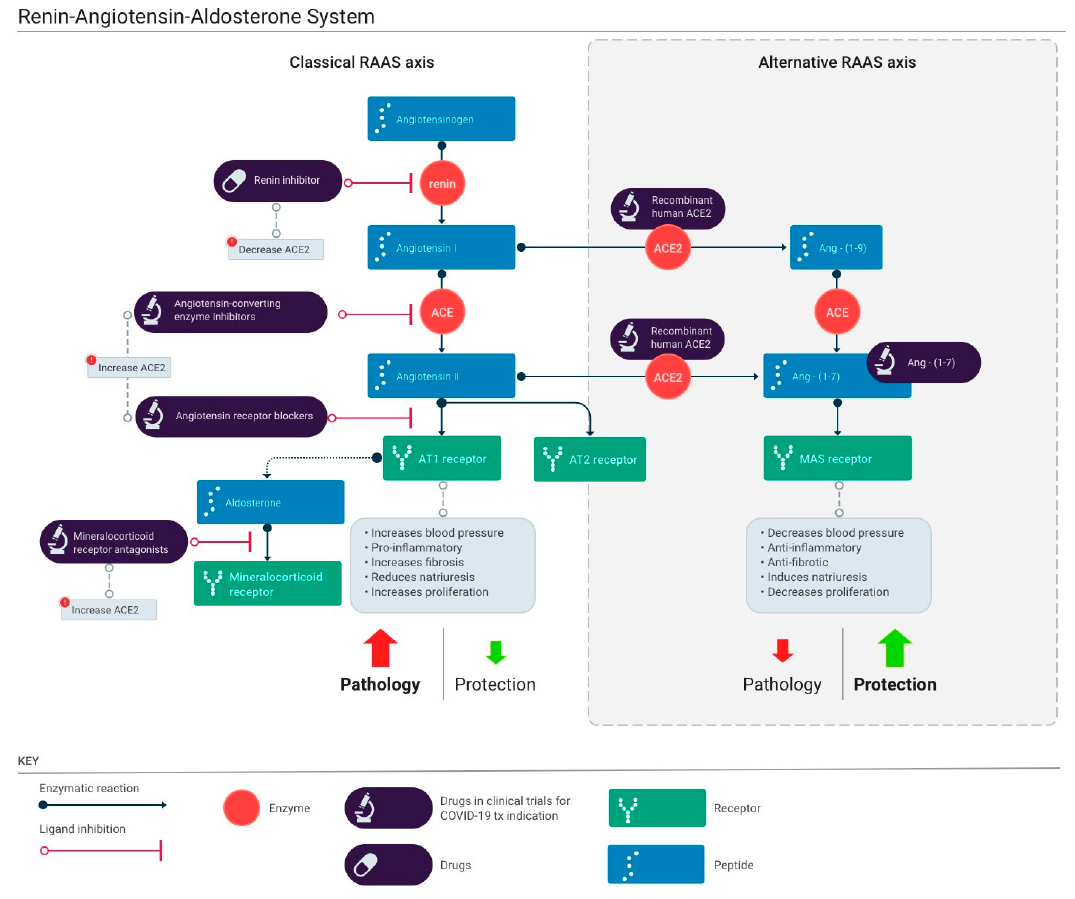
Figure 2. The renin-angiotensin-aldosterone system (RAAS) cascade, RAAS modulator actions and their potential impacts on ACE2 (Contributed by Malavika Deodhar, designed by Ernesto Lucio.)